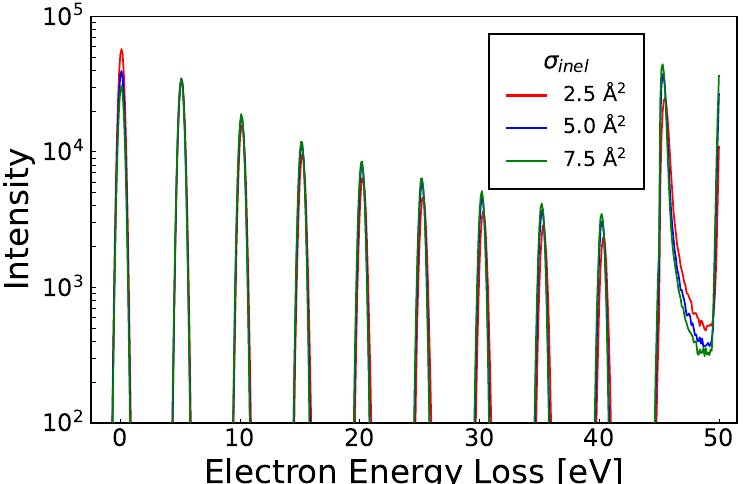
Figure A4. EELS for elastic and a single inelastic cross-section, with varying relative magnitude. An initial energy of 50 eV was used, with an inelastic threshold of 5 eV. The inelastic cross-section magnitude is shown in the legend. At 0 eV energy loss an elastic peak exists, followed by threshold separated sequential inelastic peaks. Additionally, after 45 eV of energy loss, electrons exclusively undergo elastic collisions which results in an increased intensity due to their minimal energy loss. Evident in this figure is a relative elastic to inelastic ratio dependence of the EELS upon the relative magnitude of the respective